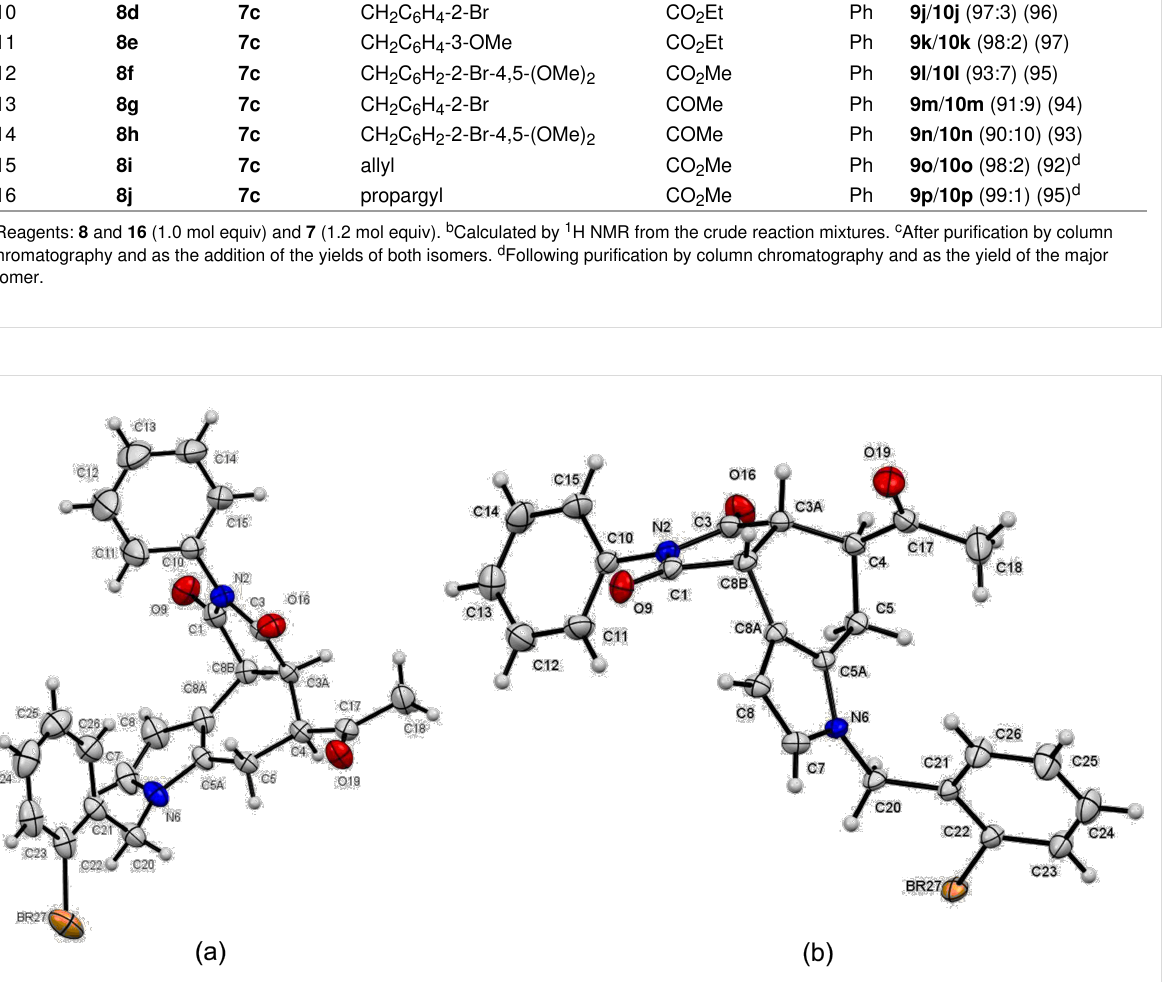
absence of the substituent bonded to the nitrogen atom of the heterocycle. Since it is not clear what factors favor this relevant selectivity, the geometry and energy of the TSs were calculated for some of the diene–dienophile pairs depicted in Table 2 (vide